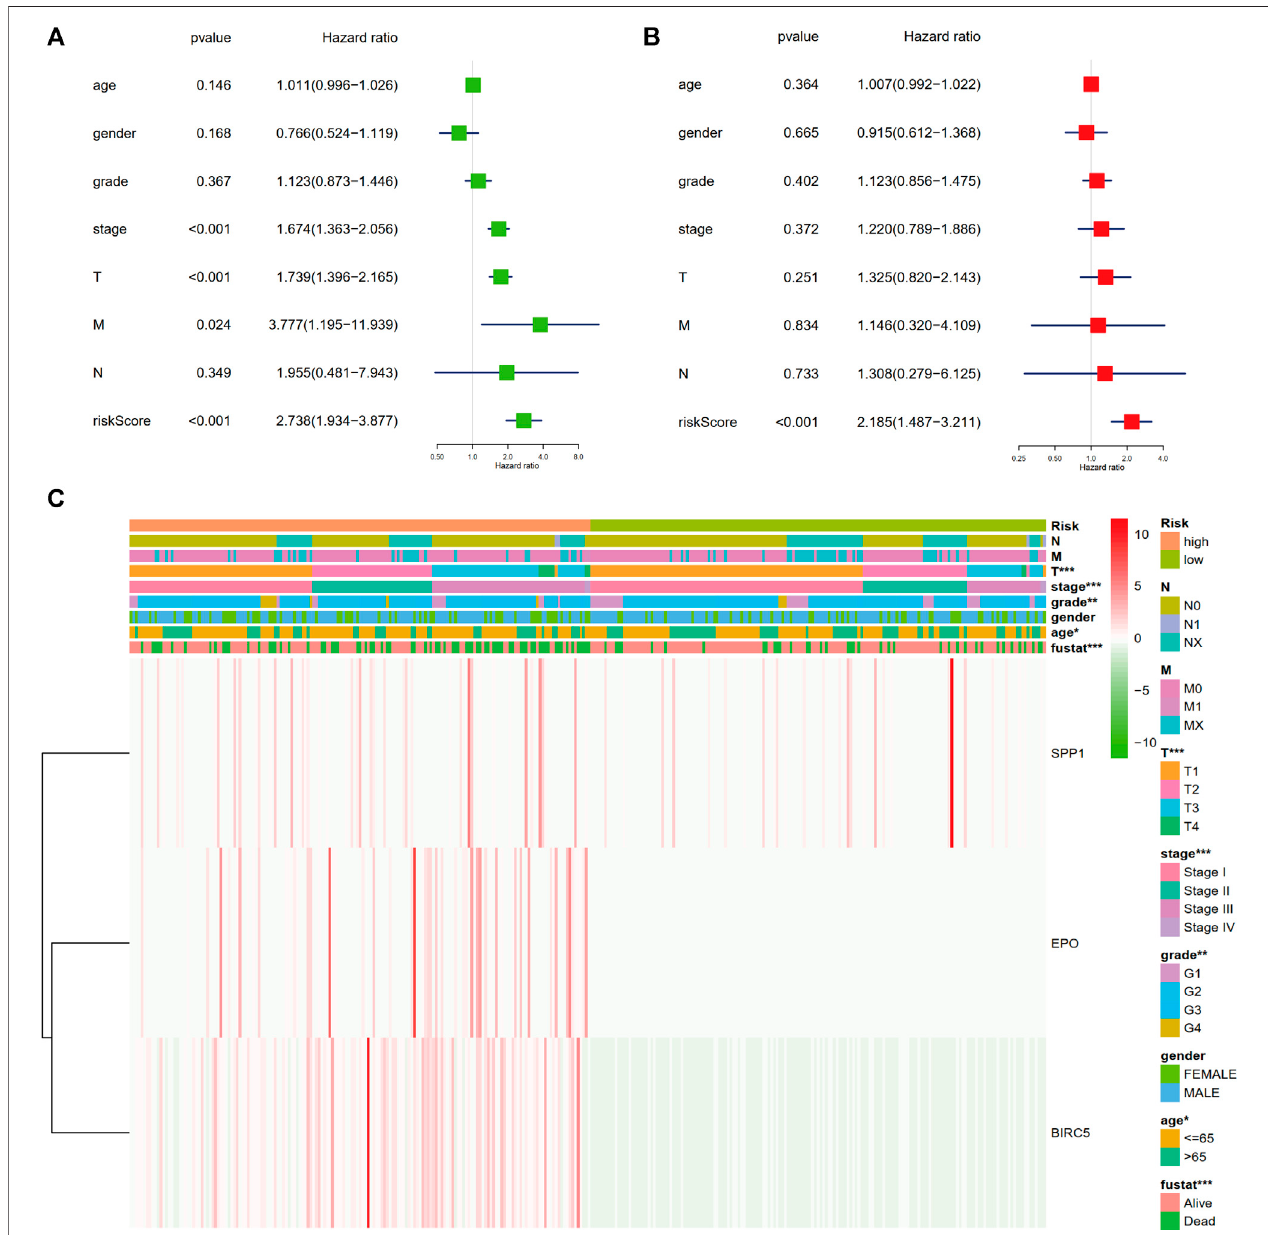
FIGURE 4 | Relationship of the three-gene signature and clinical variables. (A) Univariate Cox proportional hazard regression analysis between the risk factors and overallsurvivalofHCCpatients. (B) MultivariateCoxproportionalhazardregressionanalysisbetweentheriskfactorsandoverallsurvivalofHCCpatients. (C) Heatmapof the correlation analysis between gene signature and clinical pathological parameters of the HCC patients in the training set (* p < 0.05, ** p < 0.01, *** p < 0.001).